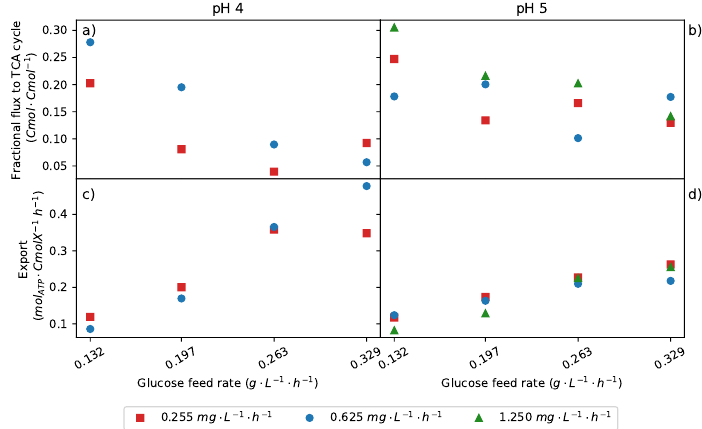
Figure 3. The effect of the urea addition rate on the energy parameters at pHs 4 and 5 ( a , b ). The fractional amount of glucose that is directed to the TCA cycle ( c , d ). The ATP required to export the acids produced into the medium. As indicated in Table 1, repeat experiments were conducted, and the average values of the two experiments are presented. For the conditions that were not repeated, single fermentation values were